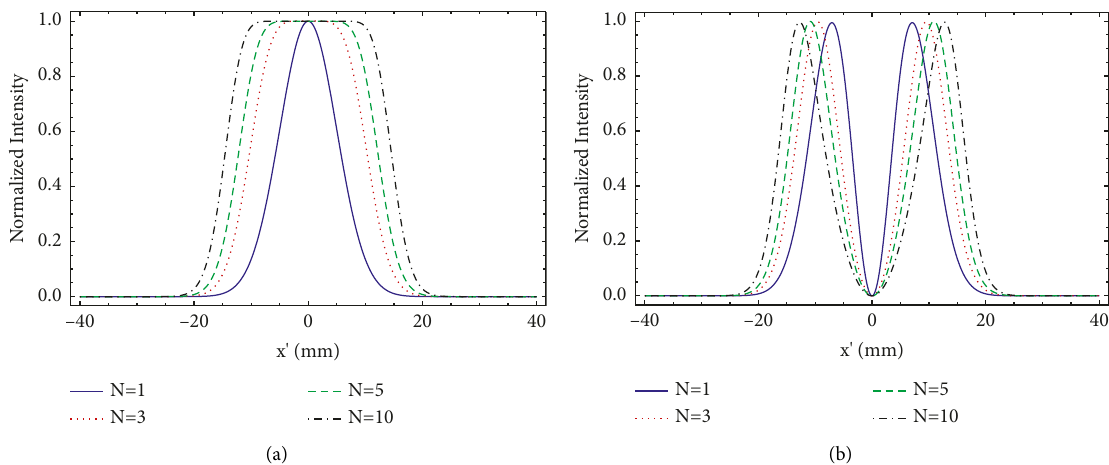
Figure 2: Normalized intensity distribution at the source plane before beam passing through anisotropic turbulent plasma for w Circular flat-topped nonvortex beam and (b) circular flat-topped vortex hollow